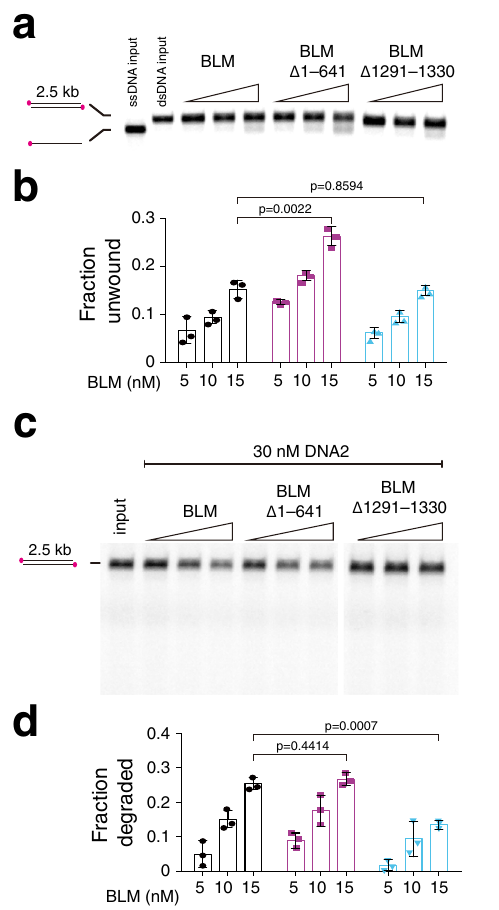
Fig. 6 Bulk biochemical analysis of BLM Δ 1 – 641 and BLM Δ 1291 – 1330 . a DNA unwinding assay with a 2.5 kb ATTO532N end-labeled substrate in assays comparing 2.5, 5, and 10 nM GFP-tagged full-length BLM with BLM Δ 1 – 641 and BLM Δ 1291 – 1330 in the presence of 200 nM RPA. b Quantitation of the DNA unwinding assay showing the fraction of unwound DNA product. The height of the bars represents the mean and error bars represent SD calculated from three separate reactions. c DNA degradation assay with a 2.5 kb ATTO532N end-labeled substrate in assays comparing 2.5, 5, and 10 nM full-length BLM with BLM Δ 1 – 641 and BLM Δ 1291 – 1330 in the presence of 30 nM DNA2 and 200 nM RPA. d DNA degradation assay quantitation showing the fraction of degraded DNA product. The height of the bars represents the mean and error bars represent SD calculated from three separate reactions.